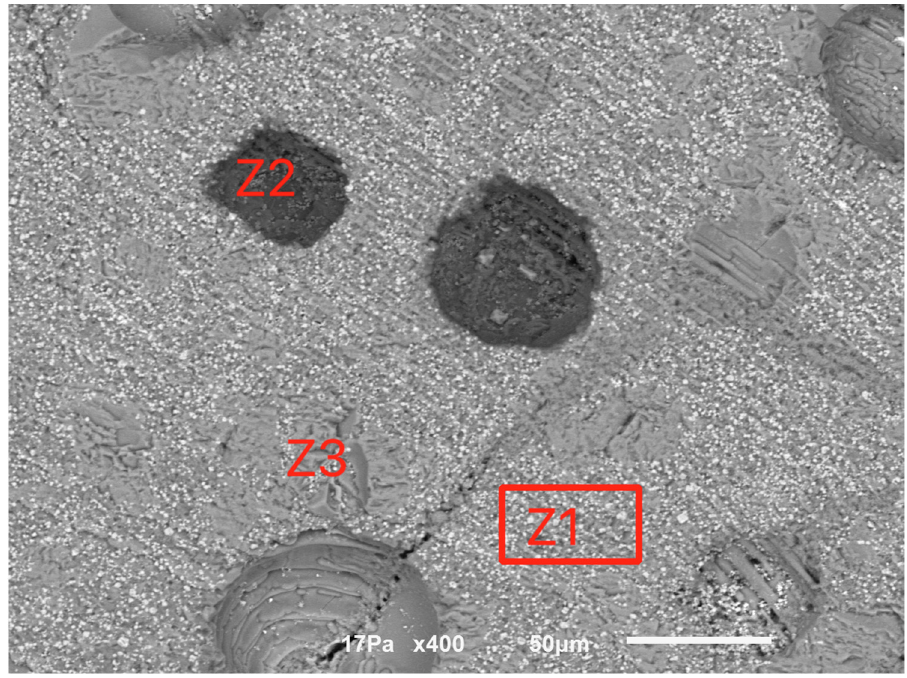
Figure 7. General view of the sample calcined at 1000 ◦